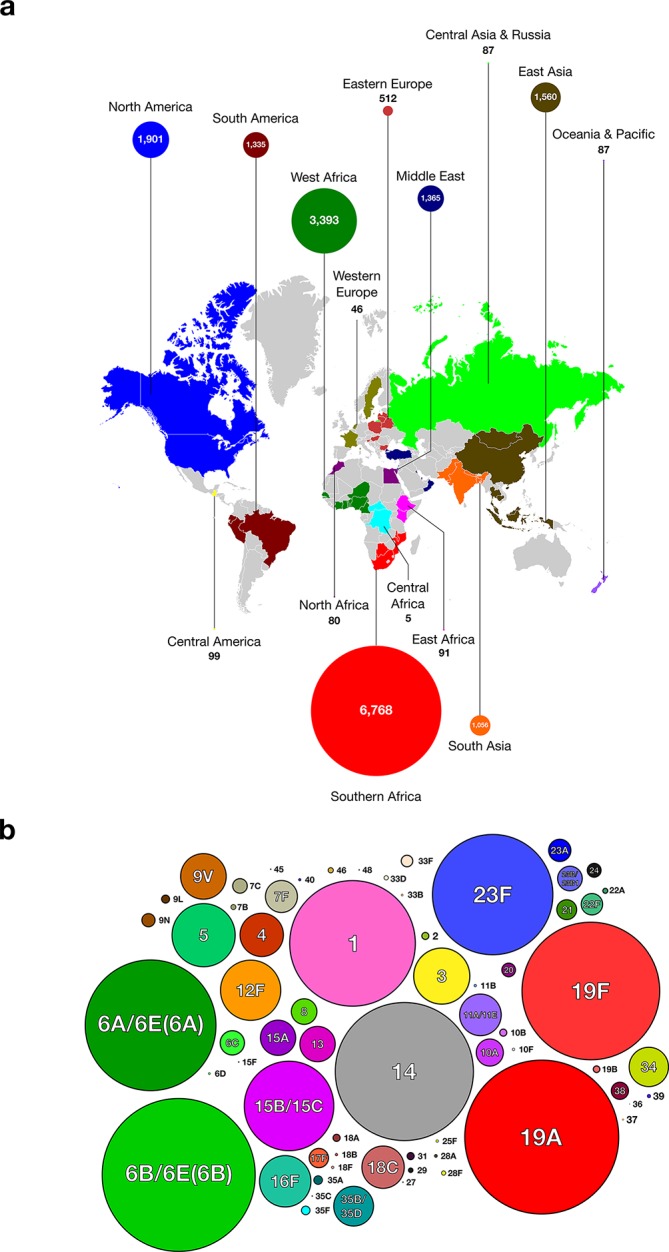
(a) World map showing the global distribution of the samples in the study dataset. (b) Bubble plot showing the 66 serotypes included in the dataset (the area of each circle is proportional to the number of samples).